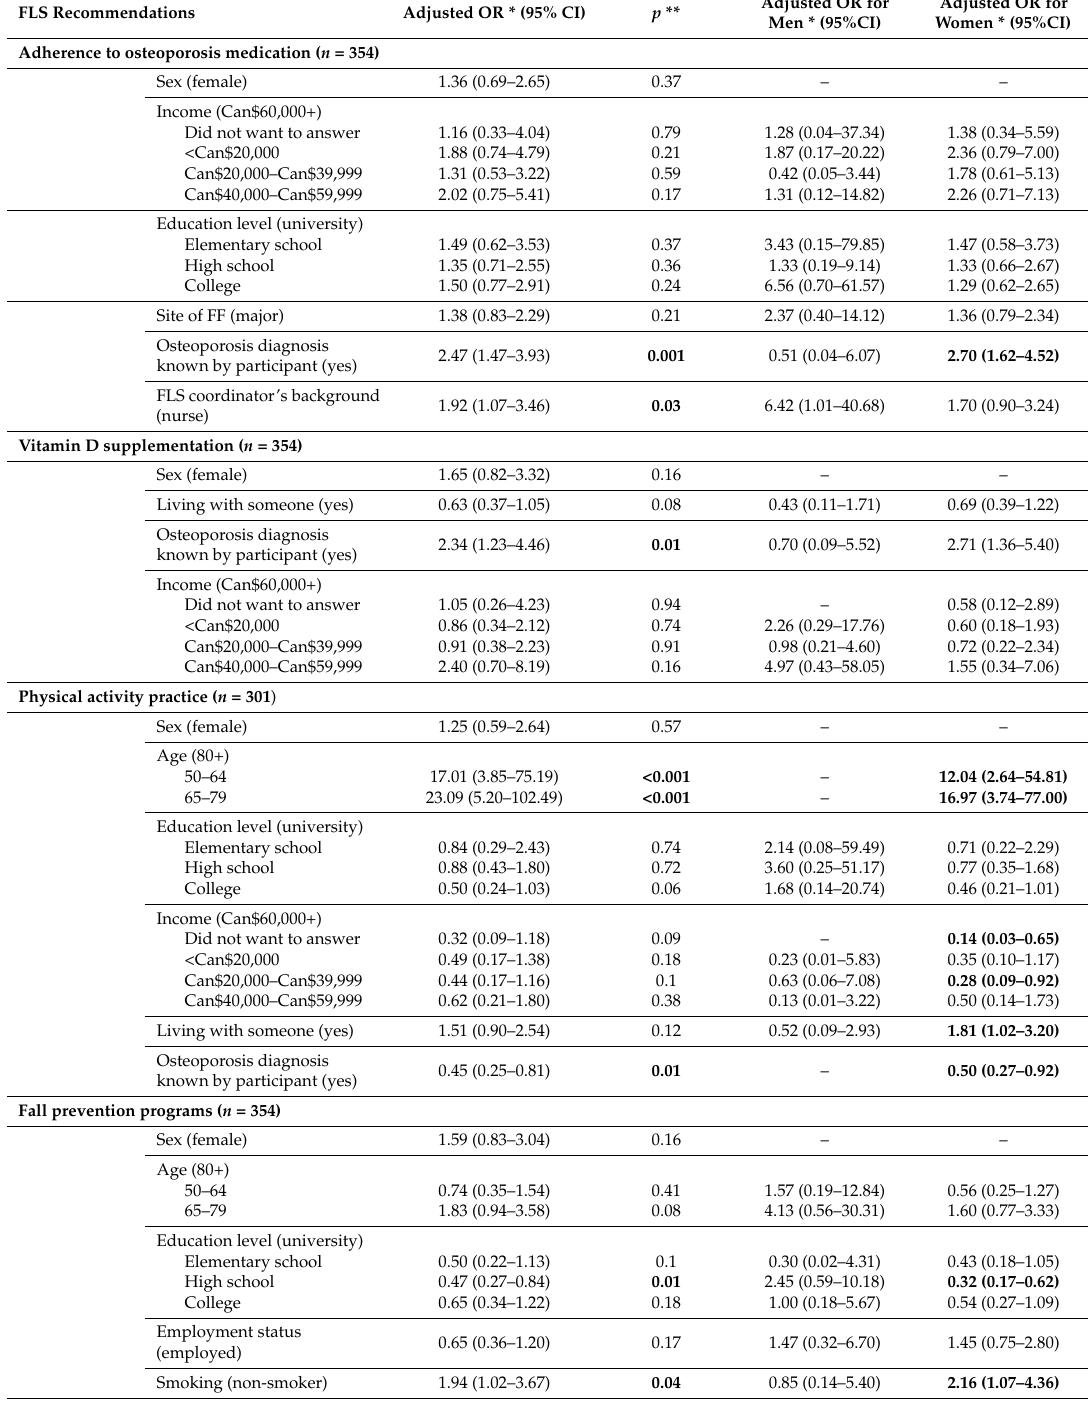
Table 2. Correlates of adherence to Fracture Liaison Service (FLS)